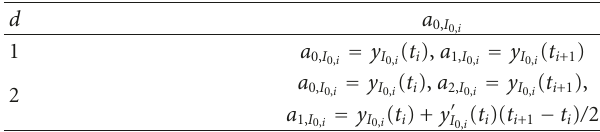
Table 2: B-spline coe ffi